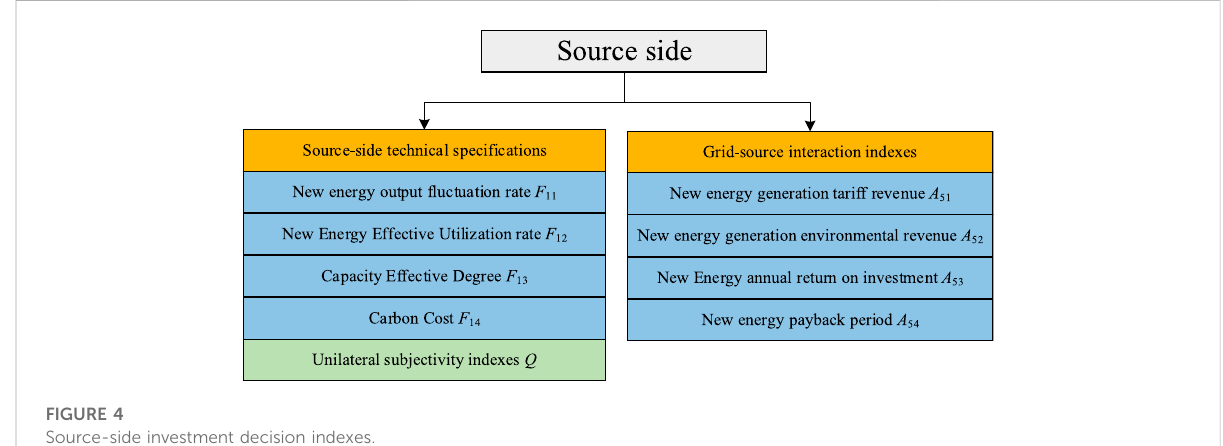
FIGURE 4 Source-side investment decision